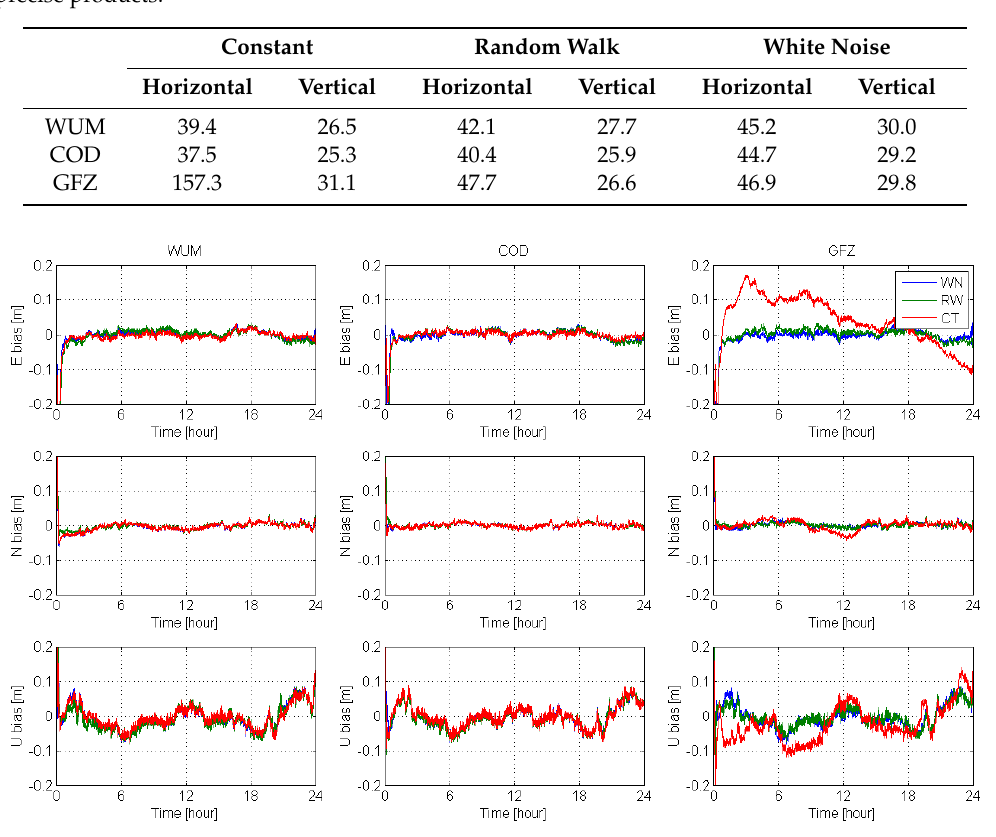
Figure 8. Positioning result of GPS/BDS PPP at station BALA on DOY 2, 2018, using constant, random walk and white noise methods. 5. Summary and Conclusions In this contribution, we comprehensively analyzed the characterization of inter-system biases (ISBs) with different precise products, receiver types and antenna types. We also investigated whether or not the ambient environment of the receiver affects the ISB characterization. Based on the analysis of ISB characterization, we implemented the GPS/BDS PPP with modeling the ISB as time constant, random walk process and white noise. A sudden jump exists in the ISB estimates between two adjacent days. It is caused by the change of satellite clock datum. The ISBs estimated with the precise products from different analysis centers have significant divergence. It is found that, in most cases, the estimated ISBs using WUM and CODE products are stable, while the variation of ISBs estimated by using GFZ products is remarkable. This is determined by the data processing strategies adopted in by different analysis centers. Moreover, even the stations equipped with the same type of receivers and antennas, the ISBs are inconsistent. This is because the stations are located in different places where the ambient environments (e.g., temperature) are different and the receiver-code biases are closely related to the temperature. The data from ultra-short baselines are used to confirm the same ambient